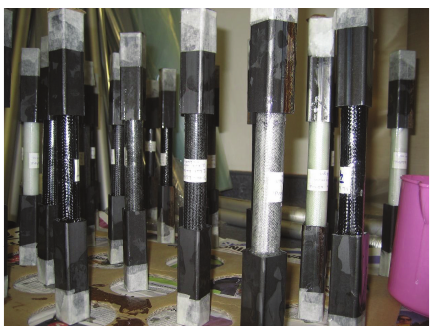
Figure 3: Shaft specimens with steel tube fitted to two ends.